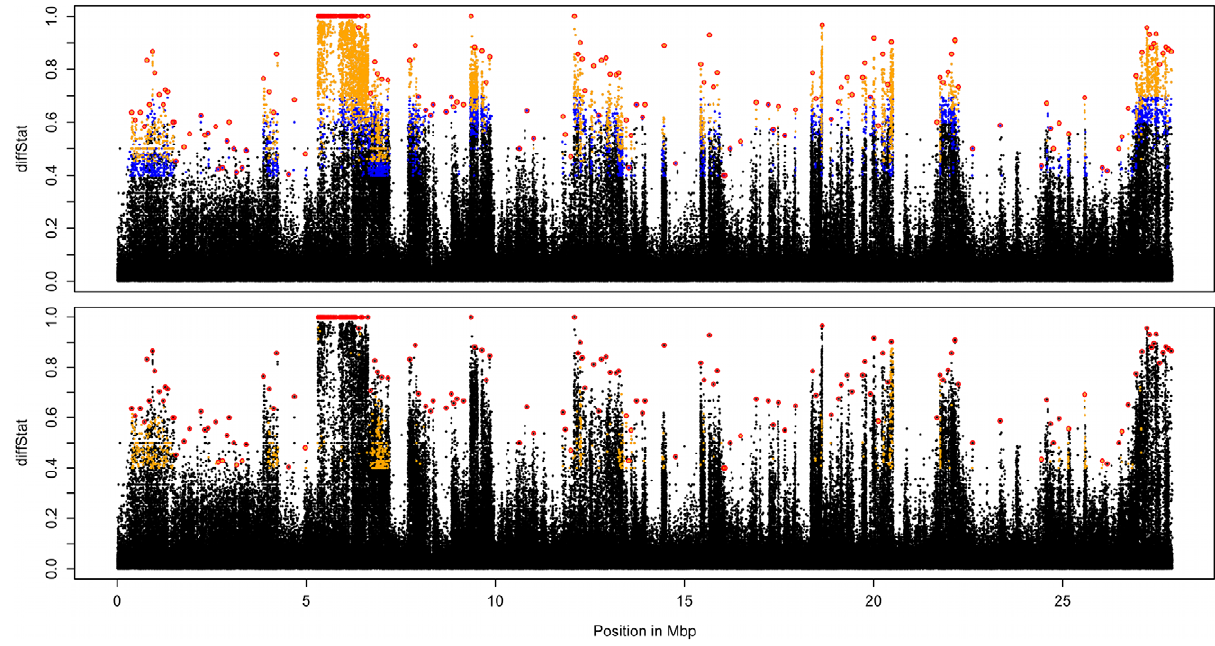
Figure 4. Differentiation on chromosome arm 3R. The diffStat is shown for each variant that had higher or lower allele frequencies in the large- selected lines compared to the small-selected lines. Above: Color coding indicates significance: black=nonsignificant variants, blue=significant variants at the permissive FDR threshold (FDR , 10%); gold=significant variants at the restrictive FDR threshold (FDR , 5%); red=peak variants. Below: Color coding indicates estimated starting allele frequency: black=all variants, gold=variants with an average control frequency , 0.05; red circles indicate peak variants, as in A.